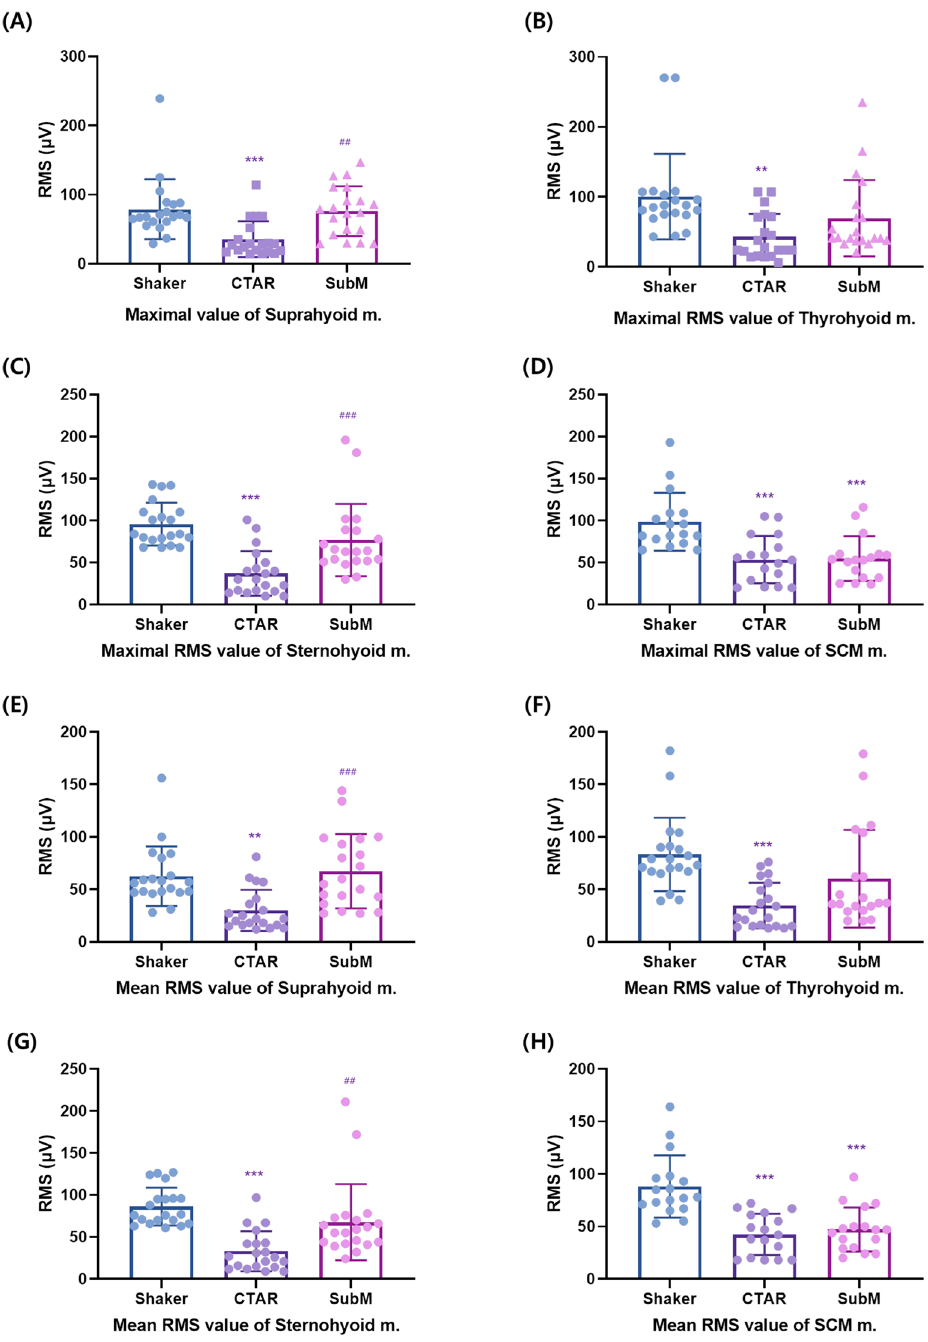
Figure 4. The maximum ( A – D ) and mean ( E – H ) RMS values of the suprahyoid, thyrohyoid, sternohyoid, and SCM muscles in patients with swallowing difficulty. The graphs were drawn using GraphPad Prism 8.0. RMS, root mean square; SCM, sternocleidomastoid. Compared with the Shaker exercise: * p < 0.05, ** p < 0.01, *** p < 0.001; compared with the chin tuck against resistance exercise: # p < 0.05, ## p < 0.01, ### p <